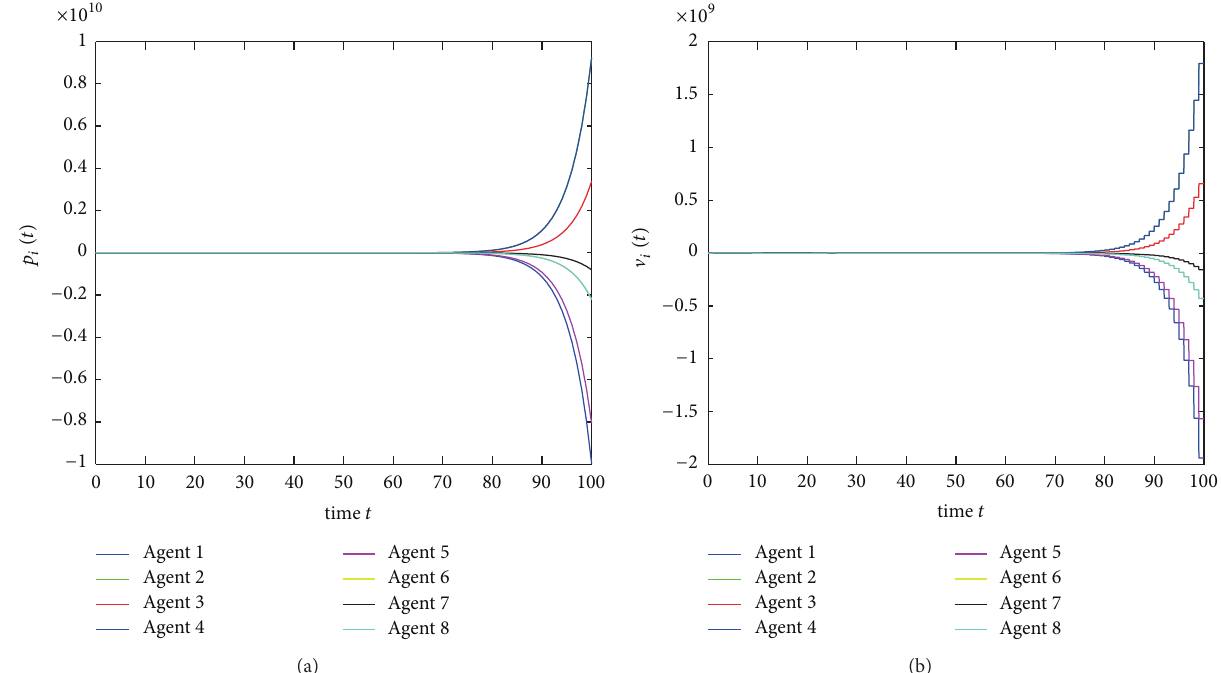
Figure 2: Trajectory of controlled multiagent system (3) with communication graph shown in Figure 1, where 𝛽 1 = 0.2 , 𝛽 2 = 0.05 , 𝛼 = 1 . Evolution of (a) 𝑝 𝑖 and (b) V 𝑖